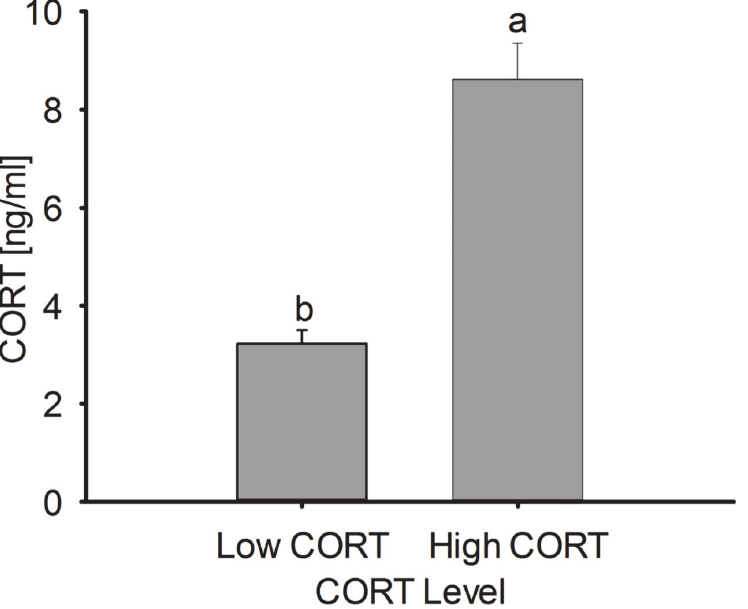
Fig 2. Determination of divergent basal CORT level groups. Low and High CORT animals grouped based on their CORT level. Birds belonging to the High CORT group have 2.7-fold higher CORT concentrations than their Low CORT counterparts. Data are means ± SE. Different letters indicate significant ( p < 0.05) differences between groups. Number of birds in the study = 60, number of birds per group =